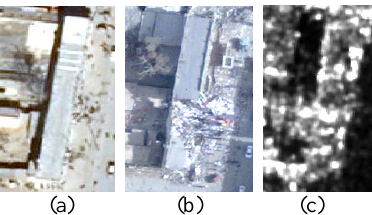
Figure 6. Pre-earthquake QuickBird image (a); post-earthquake airborne optical (b) and SAR (c) images of partial-collapsed